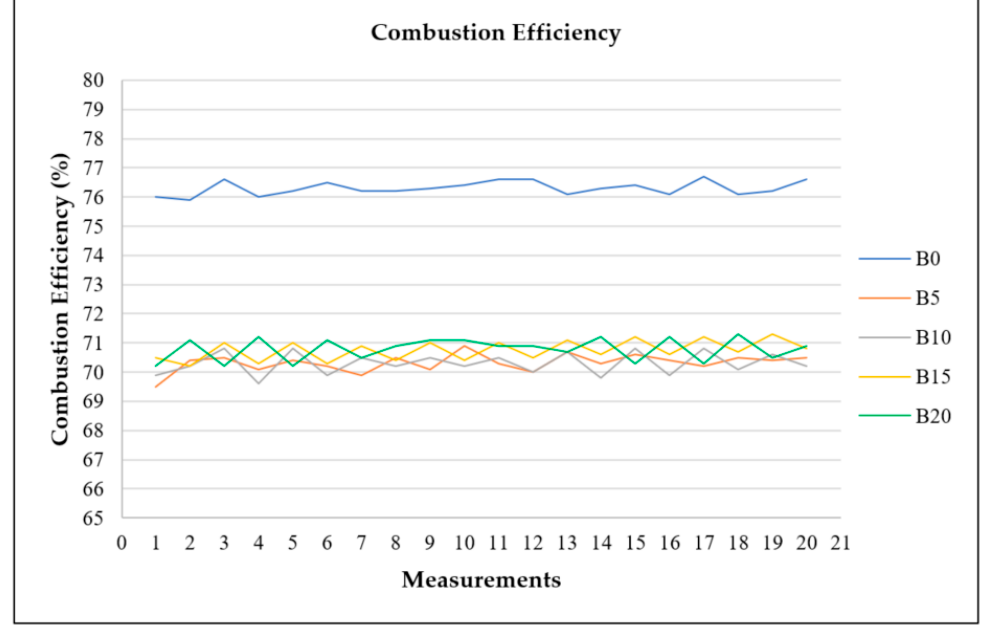
Figure 10. Combustion efficiency of the electric generator.